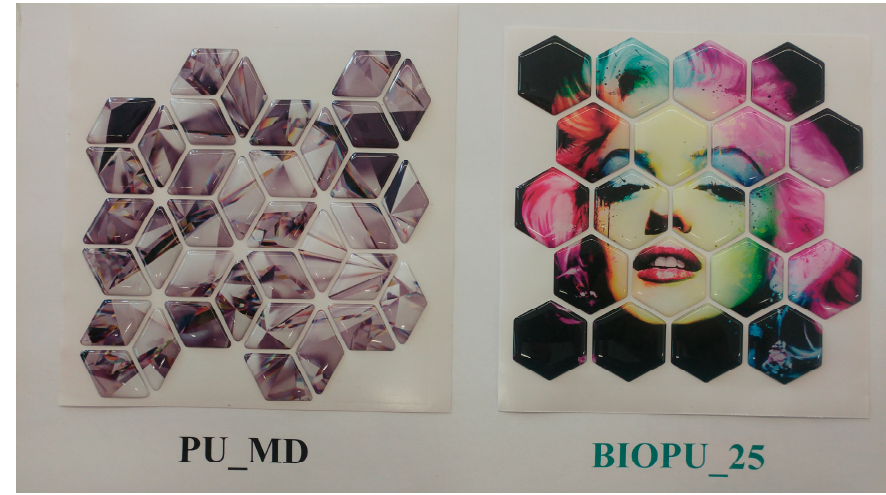
Figure 12. Comparison of tile obtained with domes resin ( PU_MD ) and BIOPU_25 (picture kindly provided by Greenswitch Company, IT).